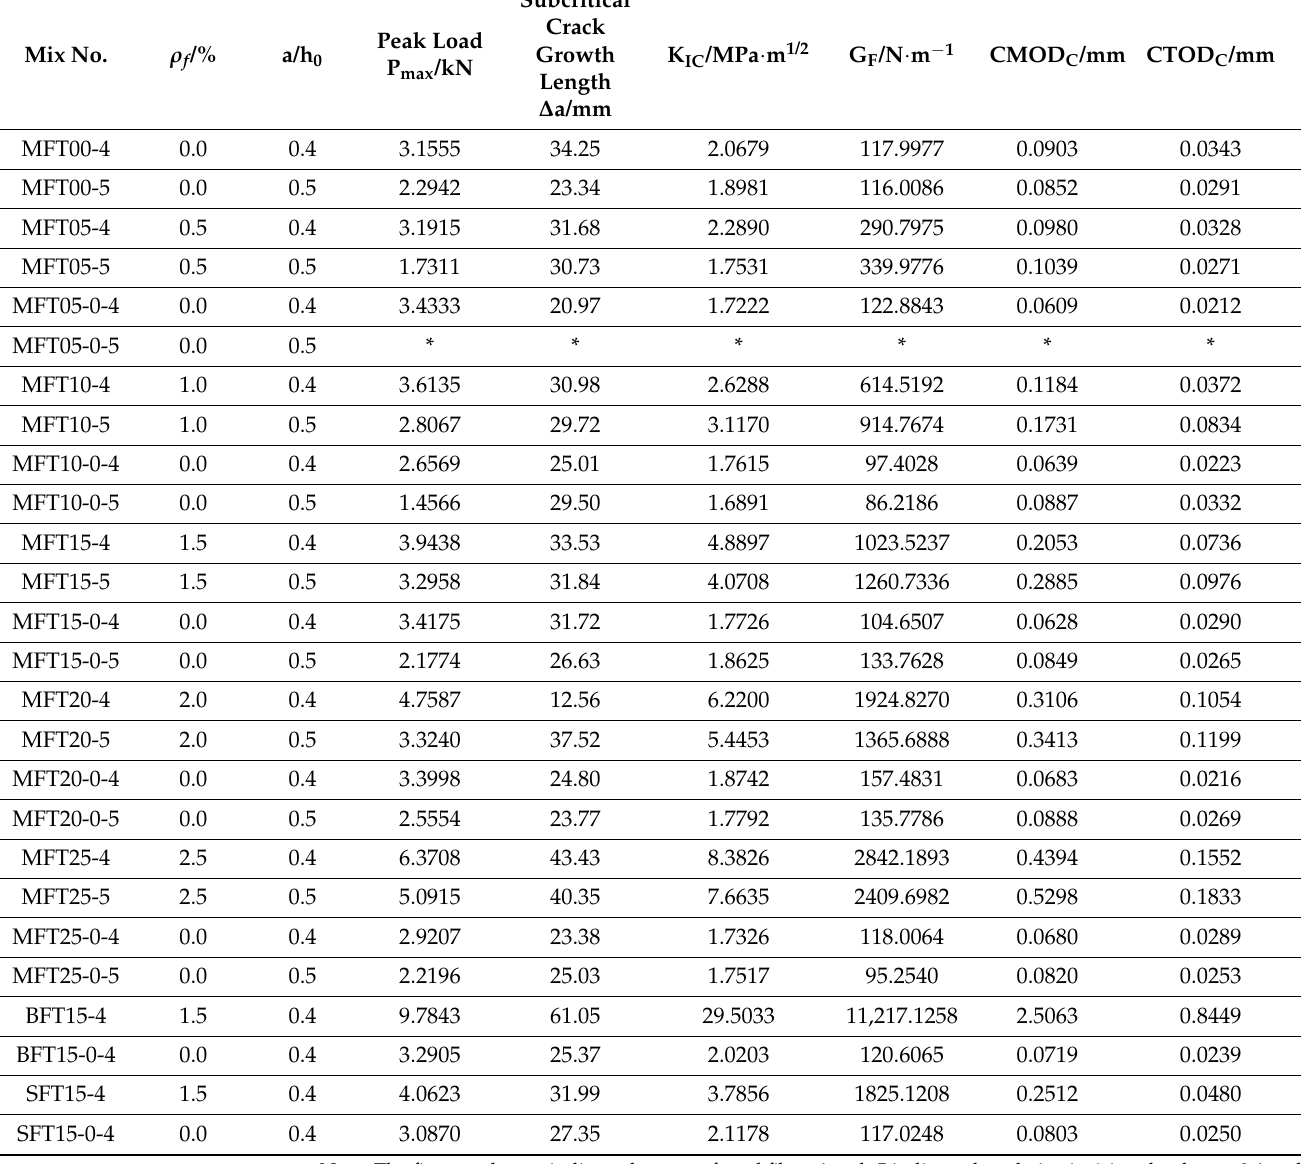
Table 3. TPBT results for fracture properties of SFHSC and HSC